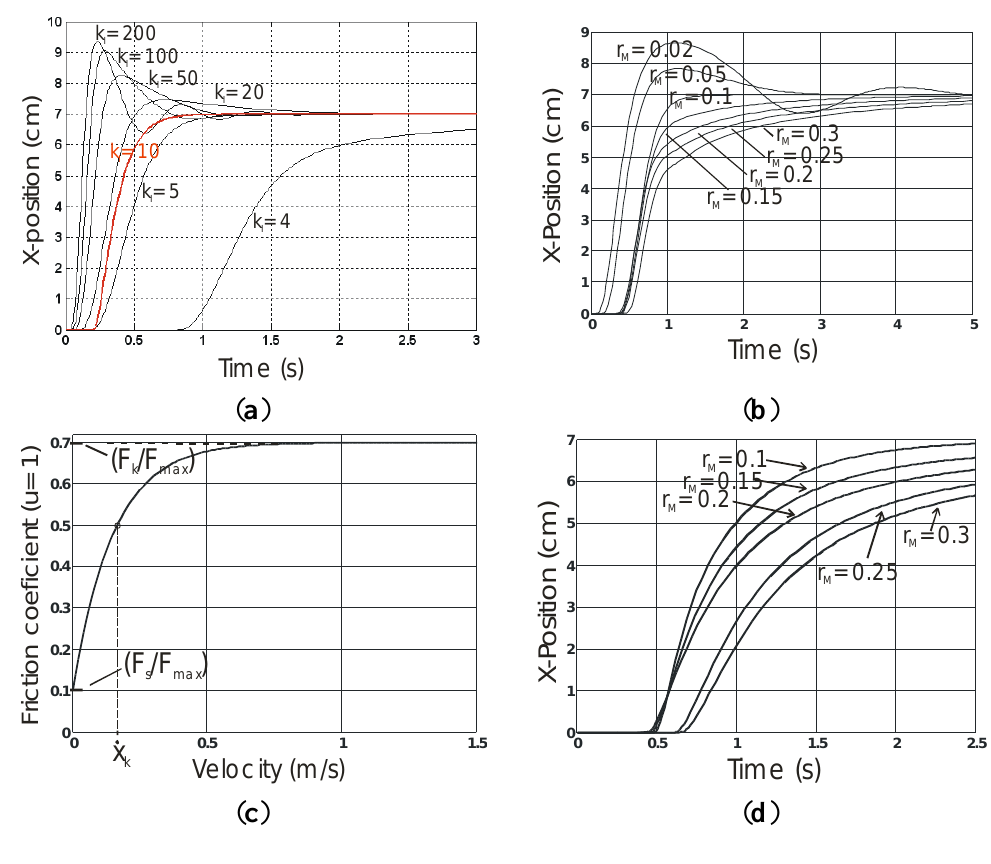
Figure 1. Simulation of the closed-loop control of the muscle model with a constant gain k single integral action for a 7 cm-position step, ( a ) Effect of k I linear viscous friction model; ( b ) Effect of load variation in the linear viscous friction case for k = 10 m −1 ·s −1 ; ( c ) Nonlinear kinetic friction model inspired by textile-physics I